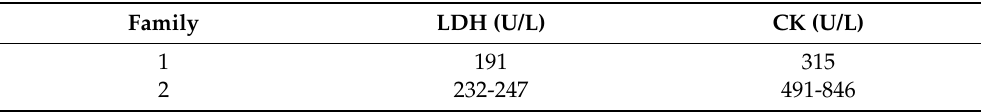
Table 1. Serum lactate dehydrogenase (LDH) and creatine kinase (CK) basal levels from index cases of both families.